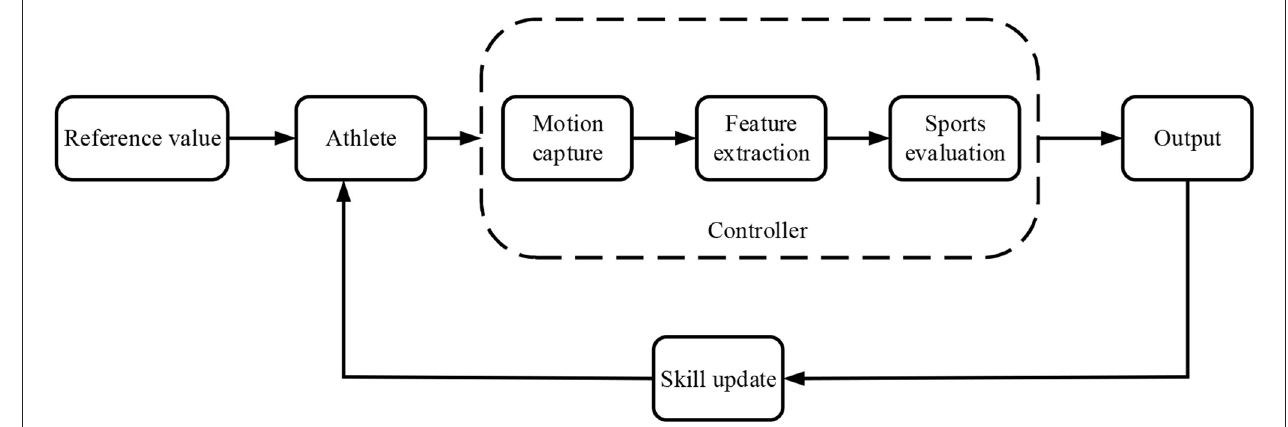
FIGURE 3 | The HCI training process of the sports coaching system.